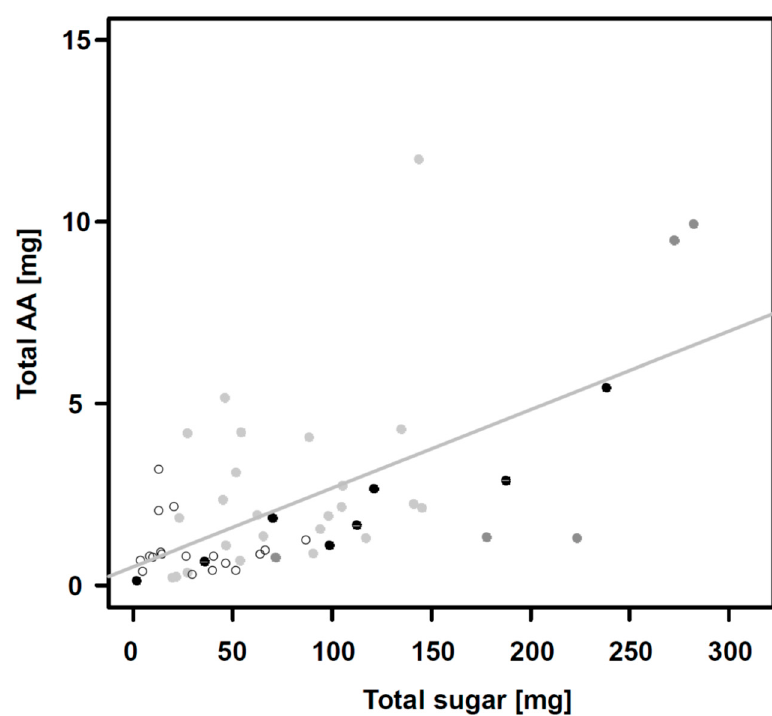
Figure 3. Ratio of total amino acids to total carbohydrates in mg (C:AA) in nectar of Knautia arvensis grown in different plant species richness communities. Each dot represents one sample with different colors indicating different plant species communities: black dots = monoculture, dark grey = 4, light grey = 8, white = 16 plant species community.